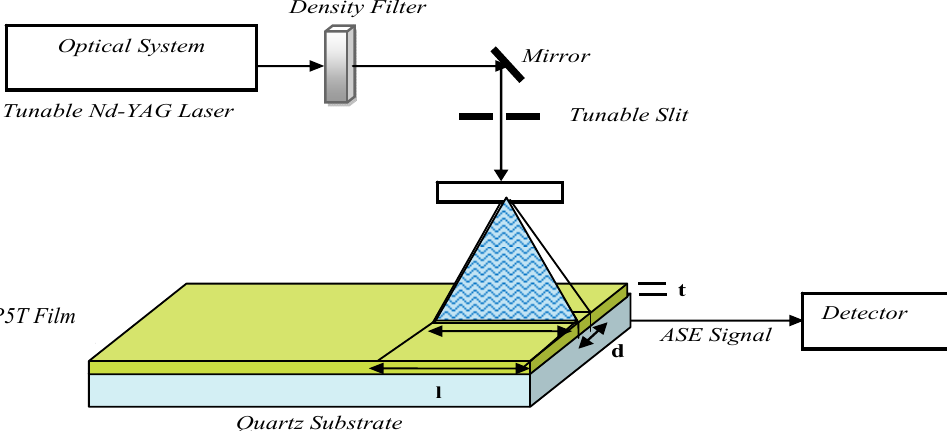
Figure 2. Schematic of the diagram amplified spontaneous (ASE) setup.